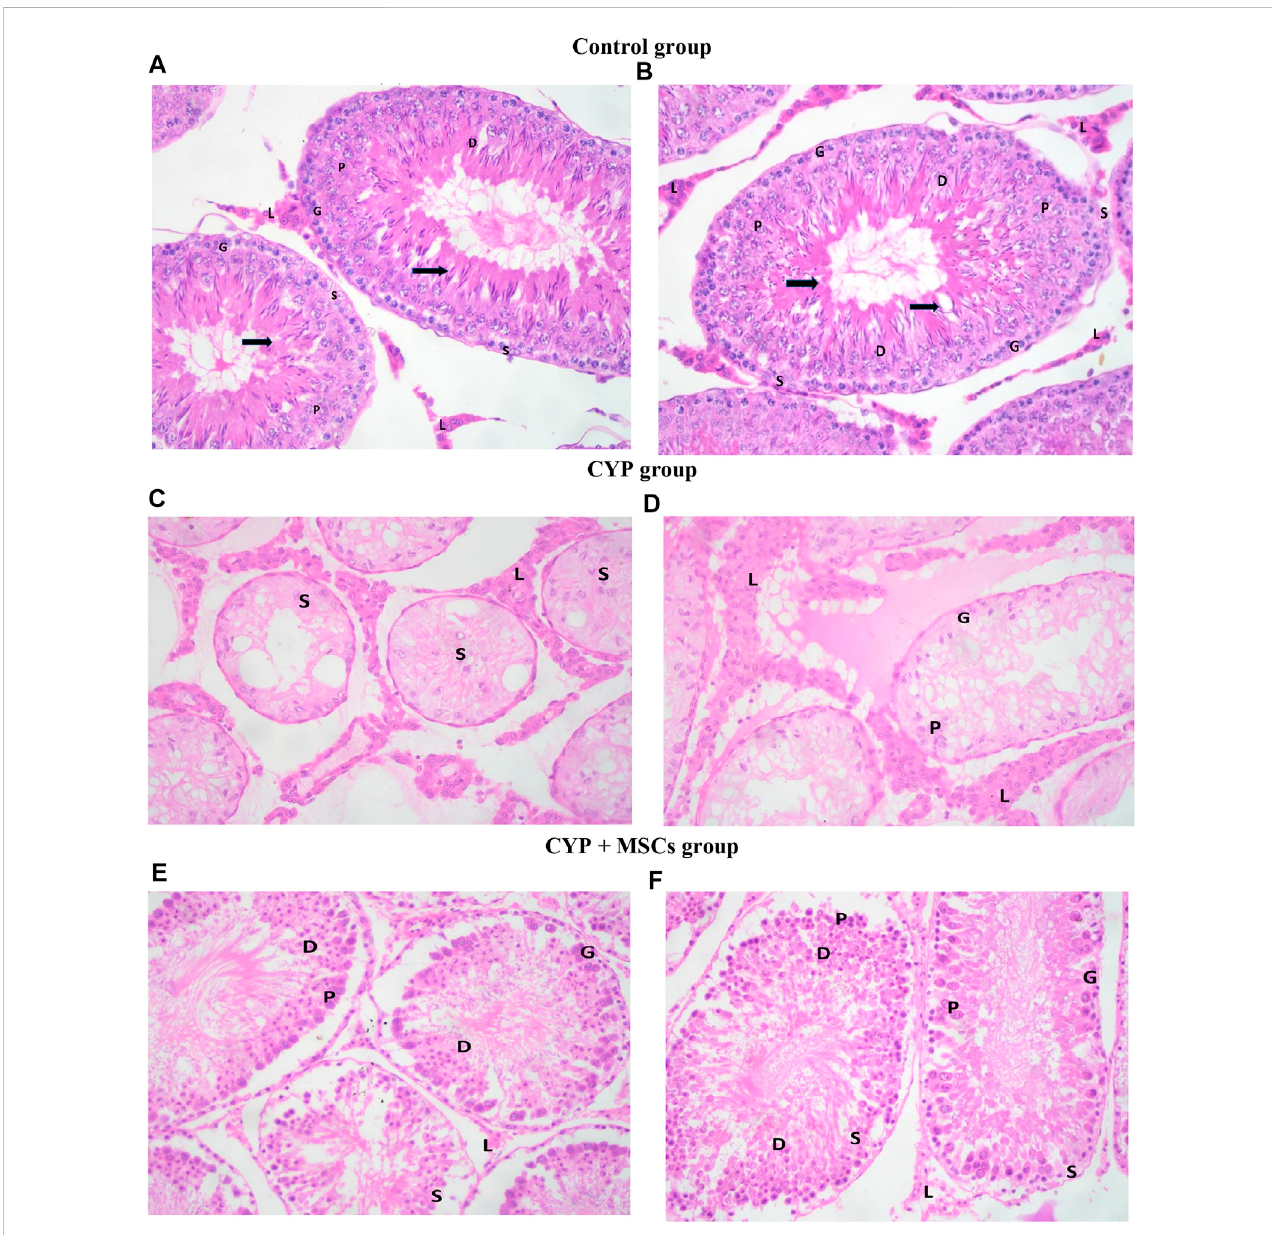
FIGURE 4 Photomicrograph of H&E-stained testis sections (A, B) control group showing seminiferous tubules. Spermatogonia cells (G) and Sertoli cells (S) lie on a normalbasementmembranethatisborderedbymyoidcells( ’’ ).Primaryspermatocytes(P),earlyspermatids(D),andspermatozoa(black-thickarrow)maybe detectedinsidethelumen.Betweenthetubules,therearegroupsofinterstitial Leydigcells(L)withvesicularnuclei (C,D) CYPgroupdemonstratinglobulesof seminiferous tubules showing almost only Sertoli cells (S), very few spermatogenic cells (G) and primary spermatocytes (P) with no evidence of spermatidsandnoevidenceofmaturationinmostoftheseminiferoustubules.TherearemanyindividualandgroupsofLeydigcellsintheinterstitialstroma(L) (E, F) CYP + MSCs group showing lobules of seminiferous tubules with spermatogenic cells (G) and Sertoli cells (S), primary spermatocytes (P) and few scattered early spermatids (D) with no evidence of maturation in most of the seminiferous tubules. There are few scattered individual and groups of Leydig cells (L) in the interstitial stroma. H&E-stained sections